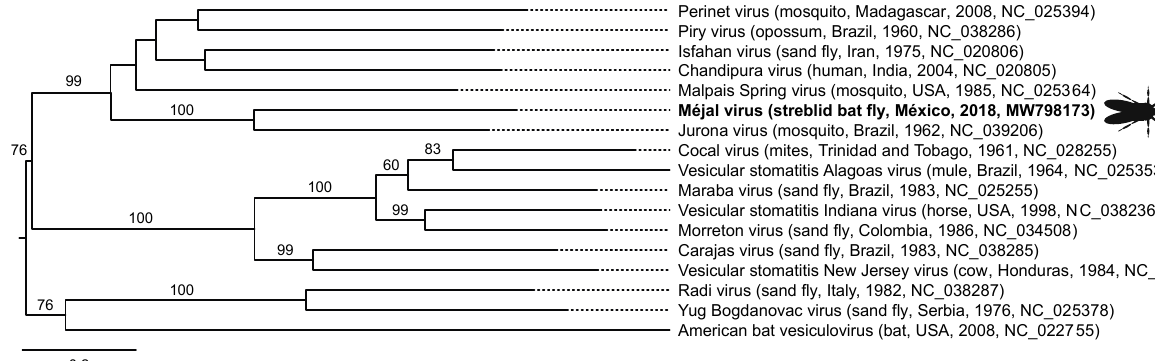
Figure 3. Maximum likelihood phylogenetic tree of vesiculoviruses based on L (polymerase) gene sequences. Virus names are followed (in parentheses) by host, country, year of collection, and GenBank accession number. Méjal virus, identified in the present study, is shown in bold type with silhouette of streblid bat fly. Numbers beside branches represent statistical confidence in clades based on 1000 bootstrap replicates; only bootstrap values ≥ 50% are shown. Scale bar = nucleotide substitutions per site.